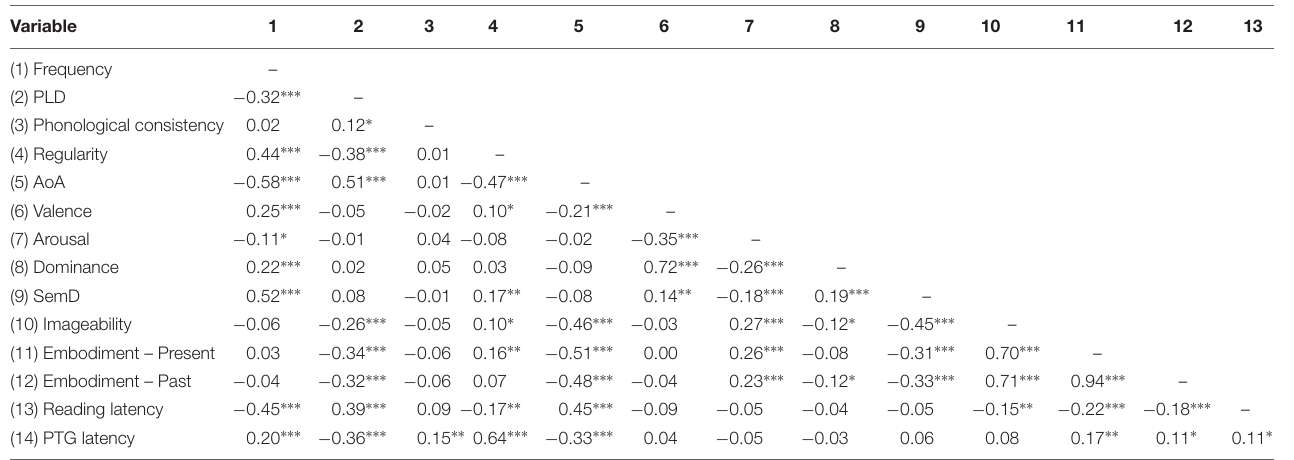
TABLE 4 | Correlations between predictor variables and dependent measures in Experiment 3a and 3b (Reading and Past Tense Generation).